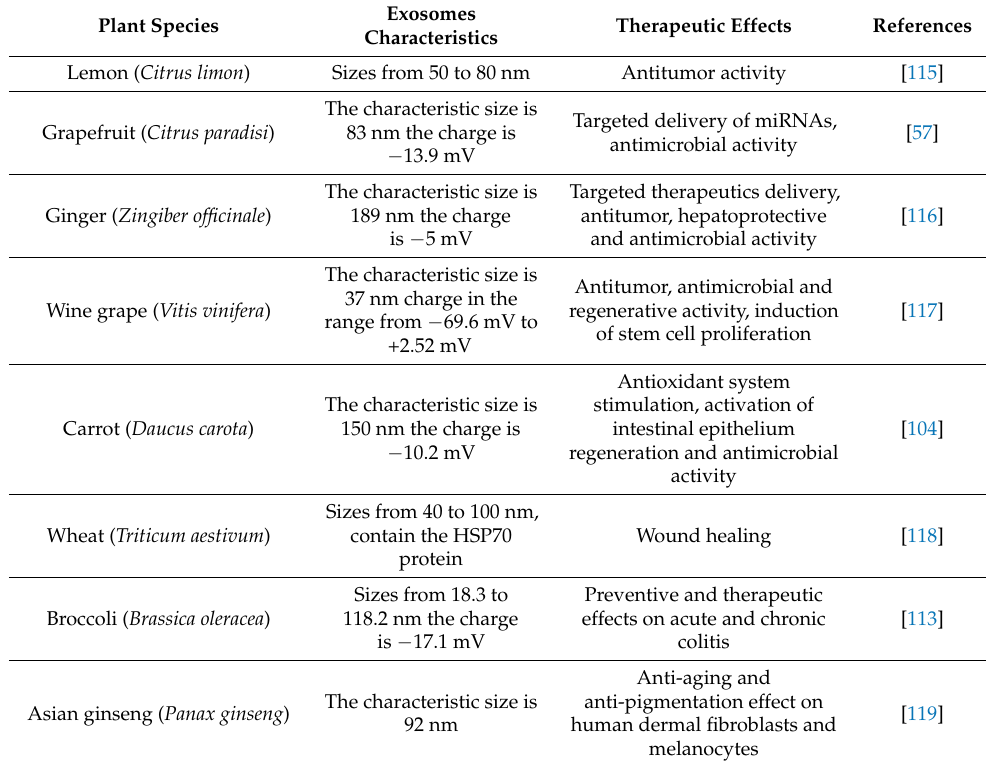
Table 3. Therapeutic effects of plant-derived